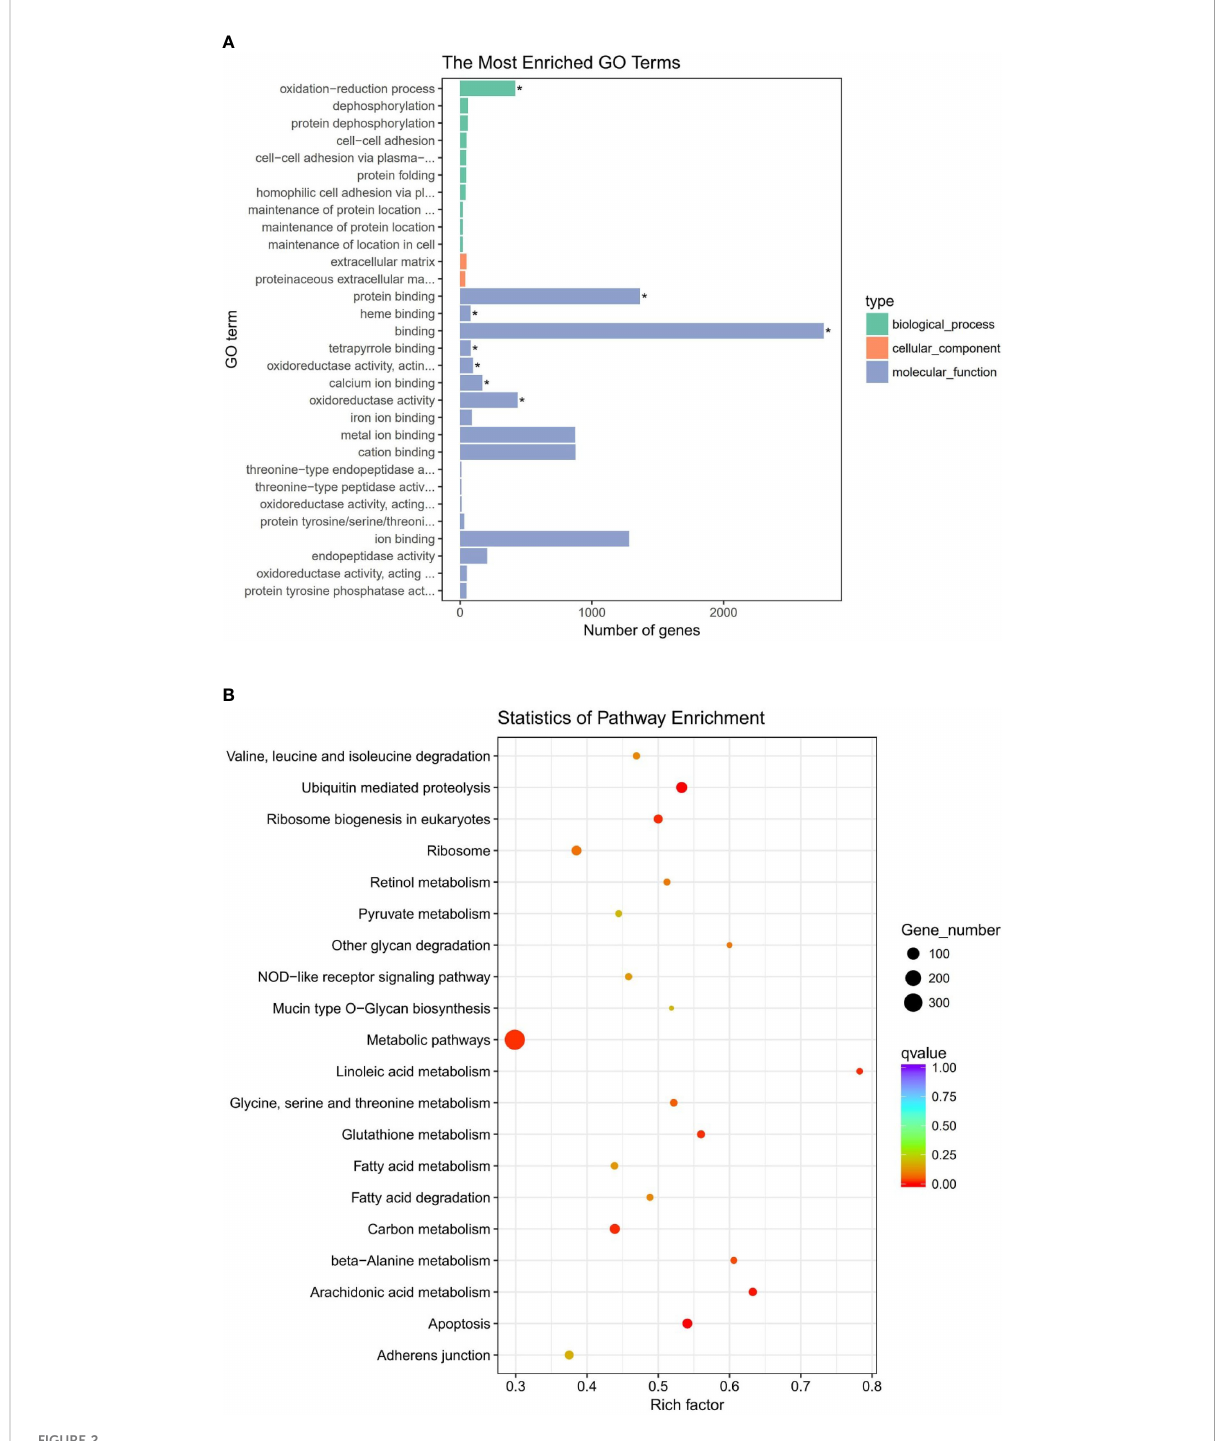
FIGURE 2 (A) Gene ontology (GO) enrichment analysis of differentially expressed genes (DEGs). Signi fi cantly enriched GO term was highlighted with star (*) inside the graph (adjusted P < 0.05). (B) Scatter plot of Kyoto Encyclopedia of Genes and Genomes (KEGG) enrichment analysis of DEGs. The vertical axis represents the pathway terms, whereas the horizontal axis signi fi es the rich factor. The size of the dot represents the number of DEGs in this pathway, and the color of the dot is consistent with different Q-value